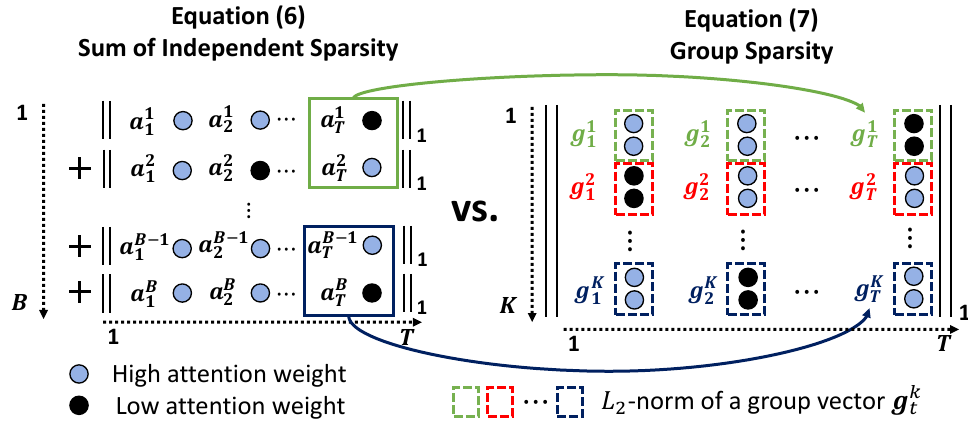
Figure 5. Comparison between the sparsity- and group-sparsity-based constraints. Unlike the sparsity-based method that adjusts each value independently, the group-sparsity-based method simultaneously controls the values associated with each